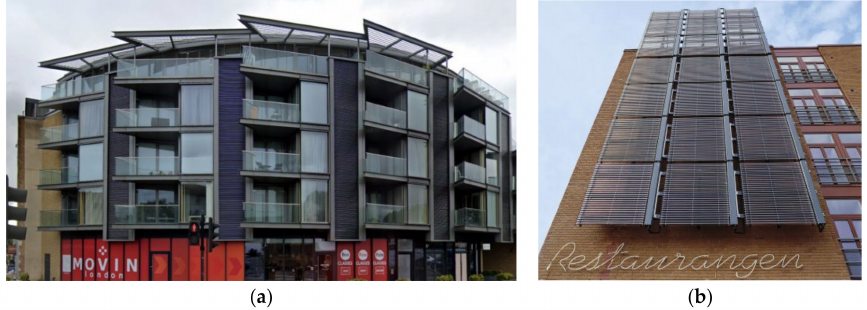
Figure 4. Integration on façade with vacuum tube collectors in residential buildings in London ( a ) and Malmö, Sweden ( b